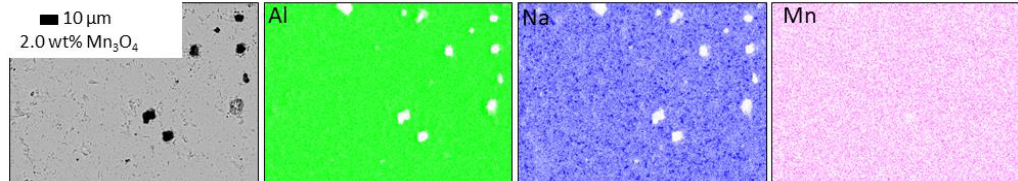
Figure 12. EDX mapping and backscattering SEM image of Mn 3 O 4 -doped, polished Na- β″ -alumina samples (sintered at 1600 °C). Al is labeled green; Na is labeled blue; Mn is labeled pink.